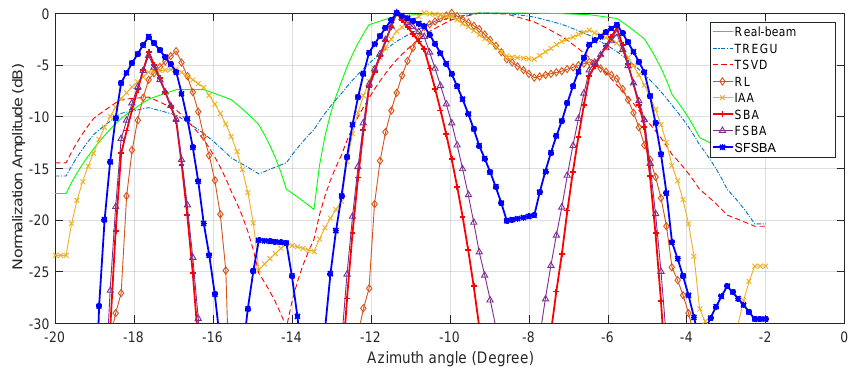
Figure 11. Profiles of local area in Figure 10.